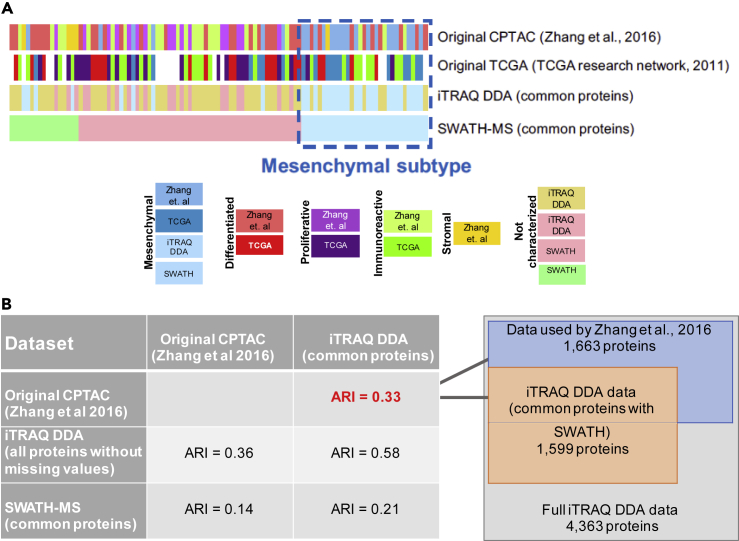
Protein (iTRAQ DDA, SWATH-MS) and mRNA-Based High-Grade Serous Ovarian Cancer Subtype Classification(A) Tumor subtype classification comparison based on gene expression (TCGA study) and relative protein abundance (original CPTAC study [Zhang et al., 2016a], and the iTRAQ DDA and SWATH-MS data from the current analysis). Subtype classification: blue, Mesenchymal; red, Differentiated; purple, Proliferative; green, Immunoreactive; yellow, Stromal.(B) Subtype classification agreement among the genomic and proteomic data assessed by the Adjusted Rand Index (ARI).